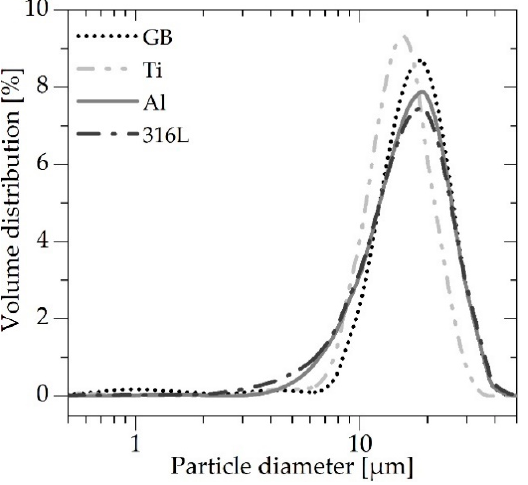
Figure 1. The volume size distribution of filler materials.